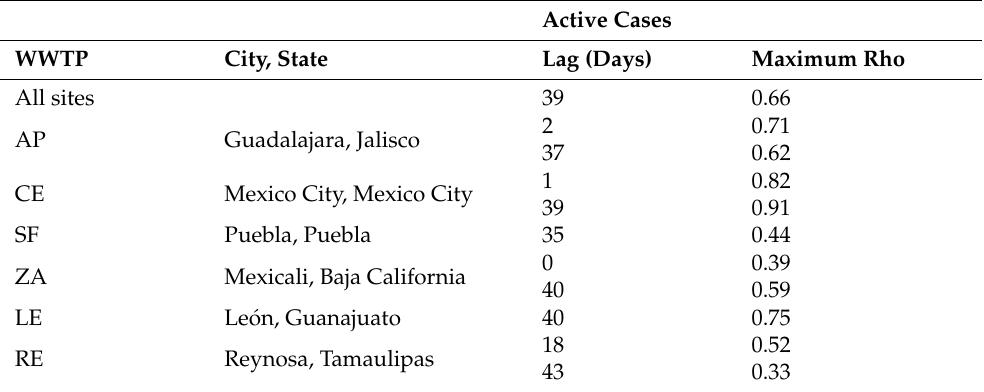
Table 2. Correlation coefficients (Rho) and corresponding lead time days for WW SARS-CoV-2 RNA load compared to the clinical surveillance metric (active cases) by site, Mexico, October–November